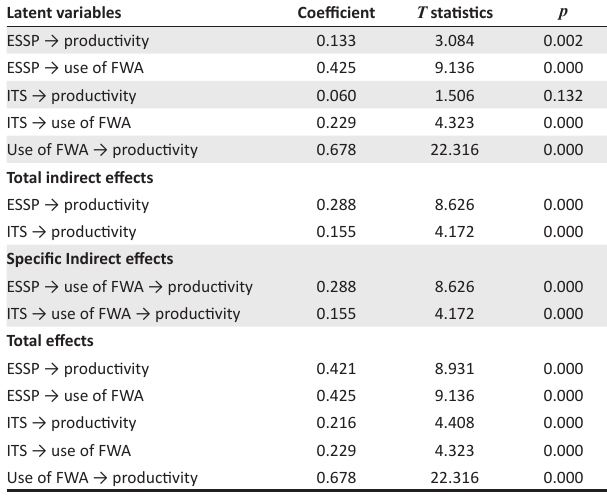
TABLE 2: Path coefficients on the mediating influence of flexible work